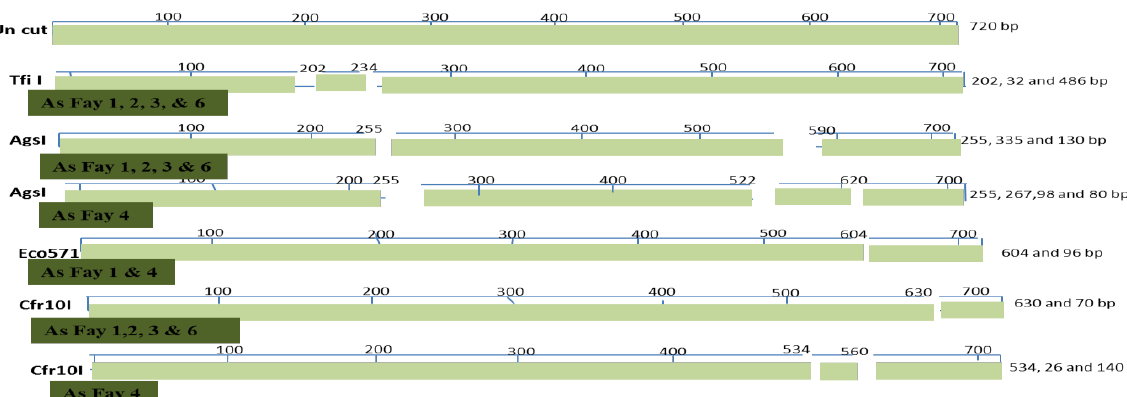
Figure 6. Restriction map of Tfi I, AgsI, Eco 571 , and Cfr10I on the ITS PCR products for Brassica accessions.